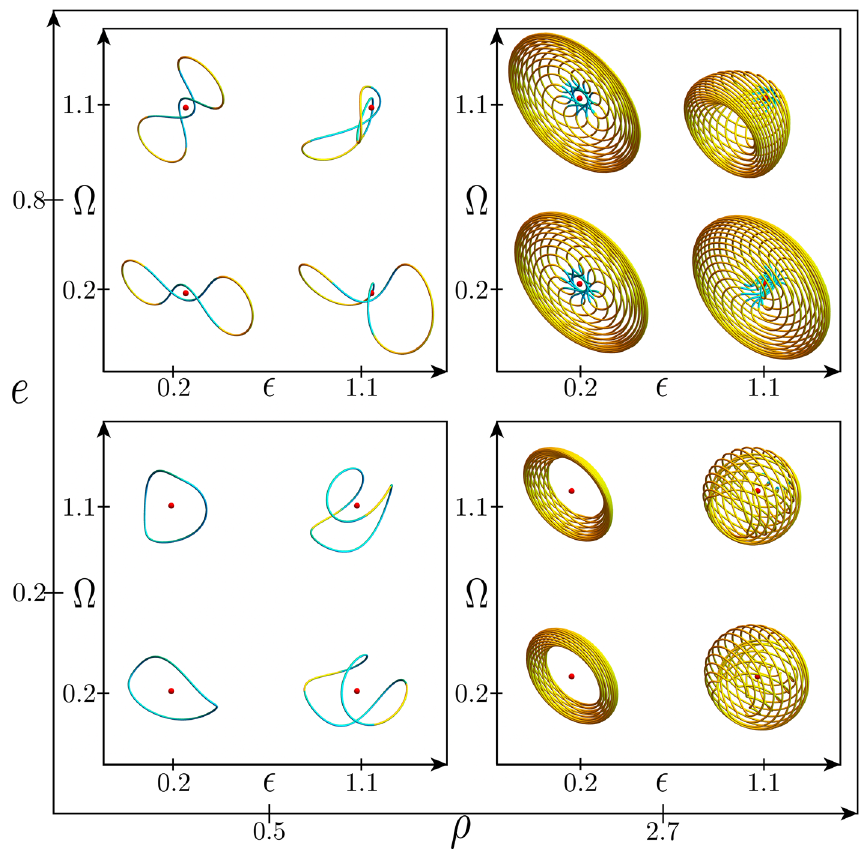
Figure 7. 4D overview. Nested plot of plots of apparent solar motion (yellow with cyan reversals) relative to an equatorial observer (red dot) for representative eccentricity e versus spin–orbit ratio ρ (outer) and nodal angle (cid:31) versus obliquity ǫ